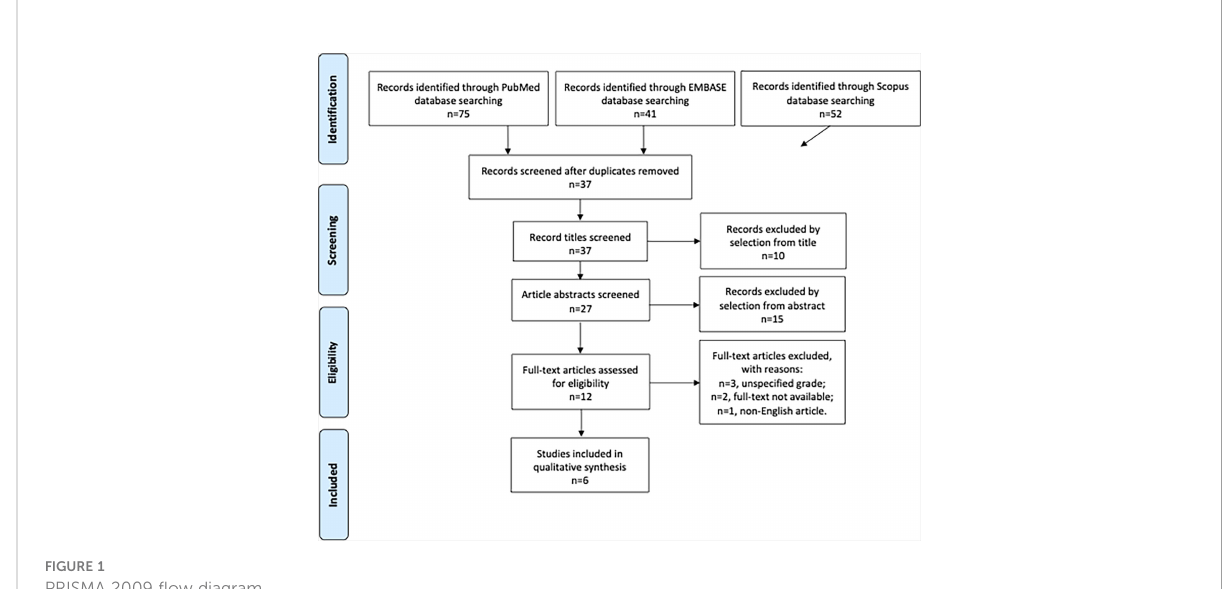
FIGURE 1 PRISMA 2009 fl ow